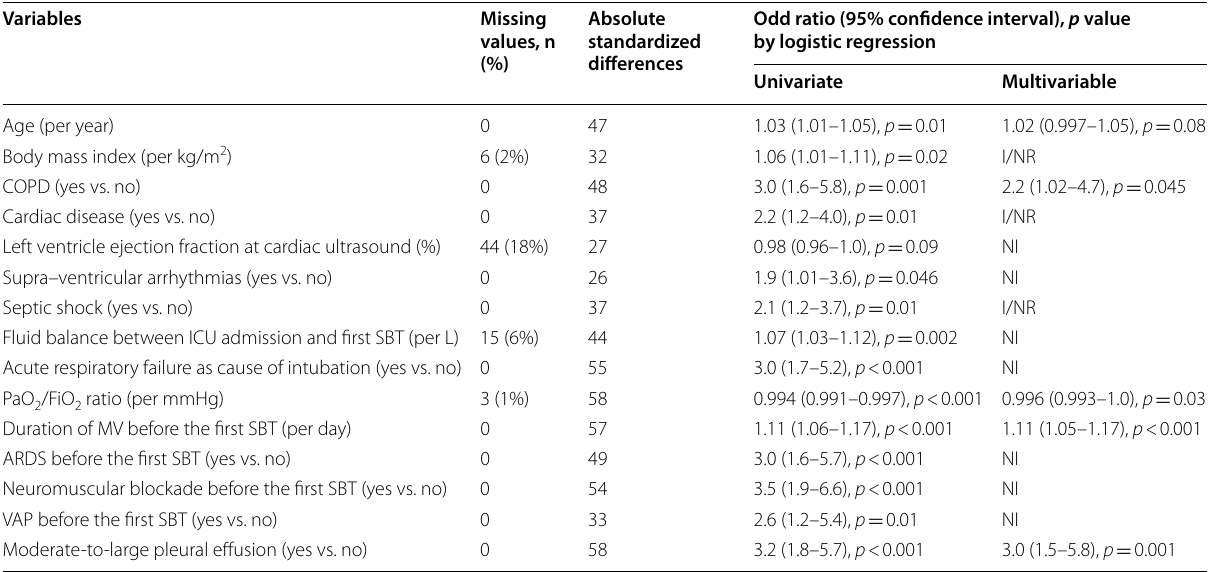
Table 4 Univariate and multivariable logistic regression of factors associated with weaning failure (n